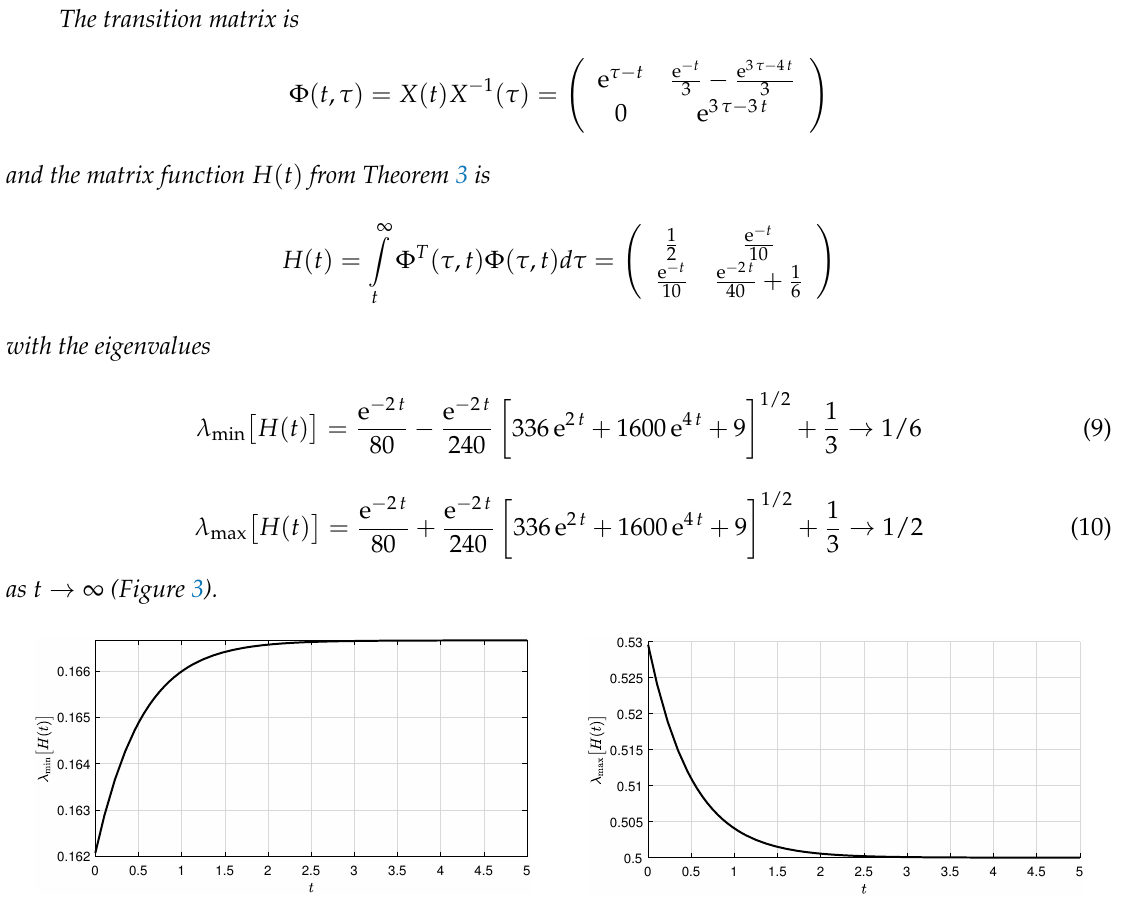
Figure 3. Time development of the functions λ min ( H ( t )) and λ max ( H ( t )) , t ≥